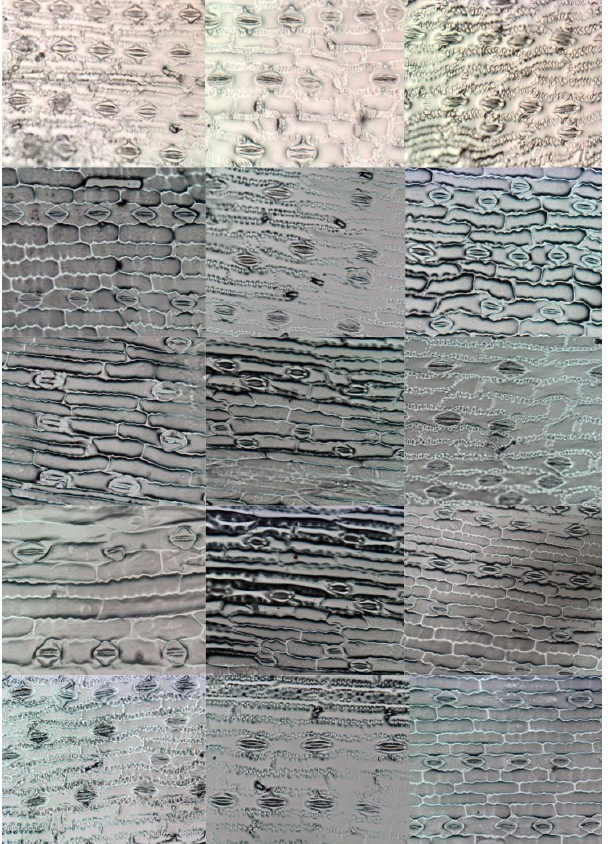
Fig 6. A subset of microscope images used in this work. Each of these images corresponds to different maize cultivars, which show great variability in stoma appearance and configuration.